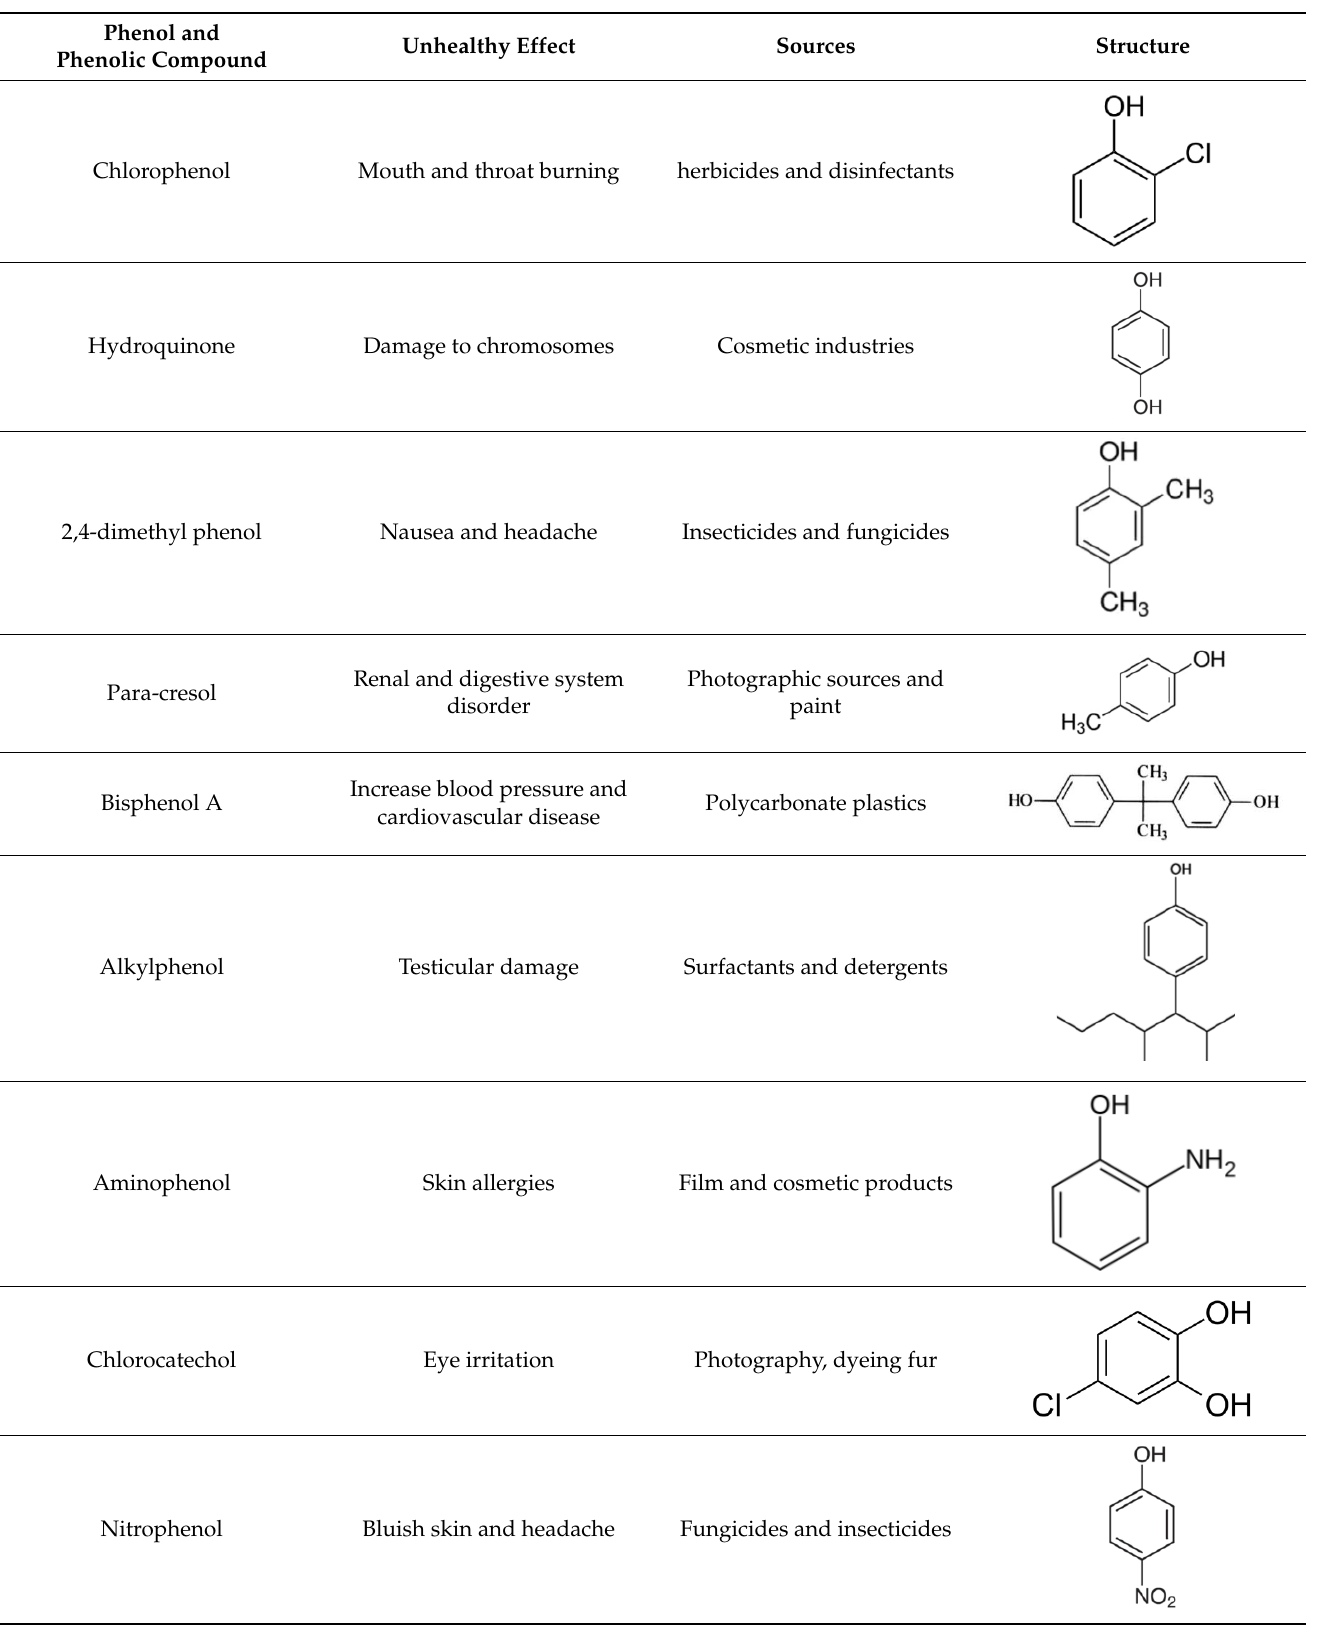
Table 4. Structure, sources, and toxic effects of phenol and phenolic compounds.